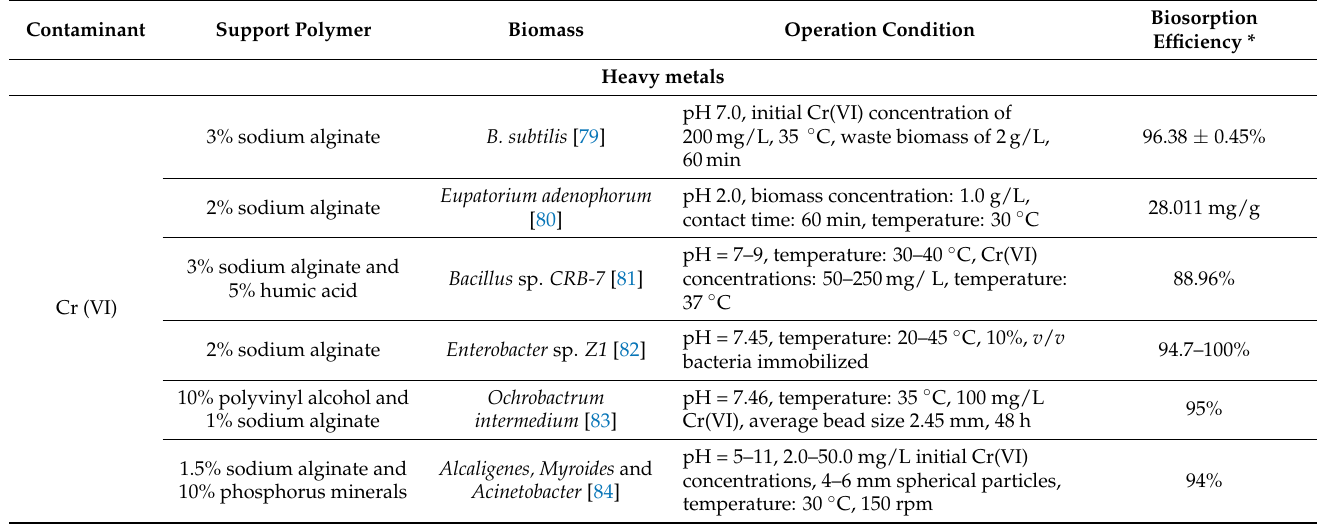
Table 4. Biosorption efficiency in different polymer/biomass biosorbents